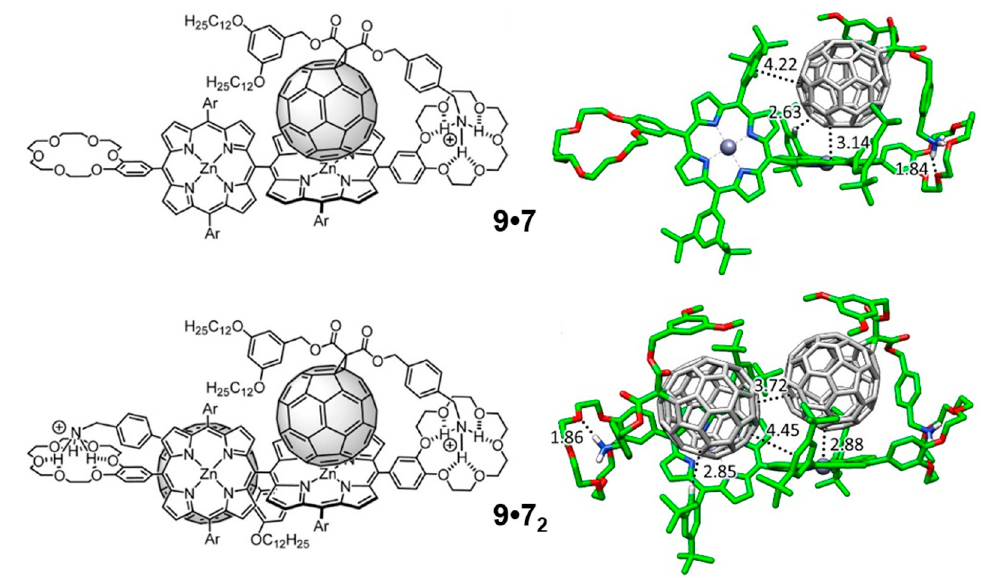
Figure 13. Chemical structure ( Left ) and minimum-energy geometry calculated at the B97-D3/(6-31G**+LANL2DZ) level ( Right ) of the supramolecular assembly of ditopic host 9 with one and two molecules of guest 7 . Except for C 60 carbon atoms depicted in grey, the following color code is used: carbon in green, nitrogen in blue, oxygen in red and hydrogen in white. Adapted with permission from [90]. Copyright 2014 American Chemical Society.